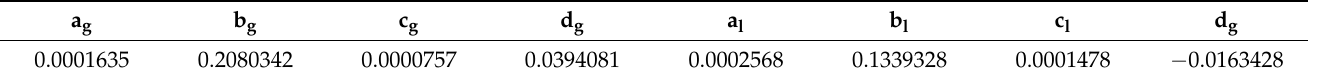
Table 1. The parameters of linear dependences of PDF min ( T ) and PDF min ( T ) /PDF max ( T ). a g b g c g d g a l b l c l d